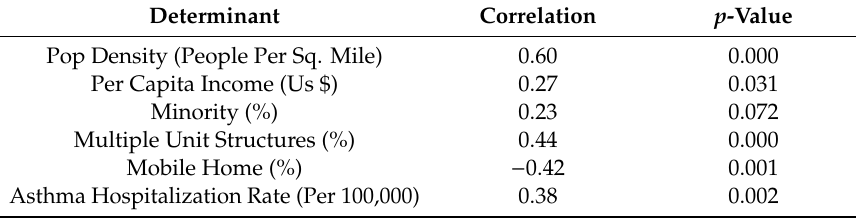
Table 5. Correlations between COVID-19 deaths (%) and social and health determinants in Colorado. Determinant